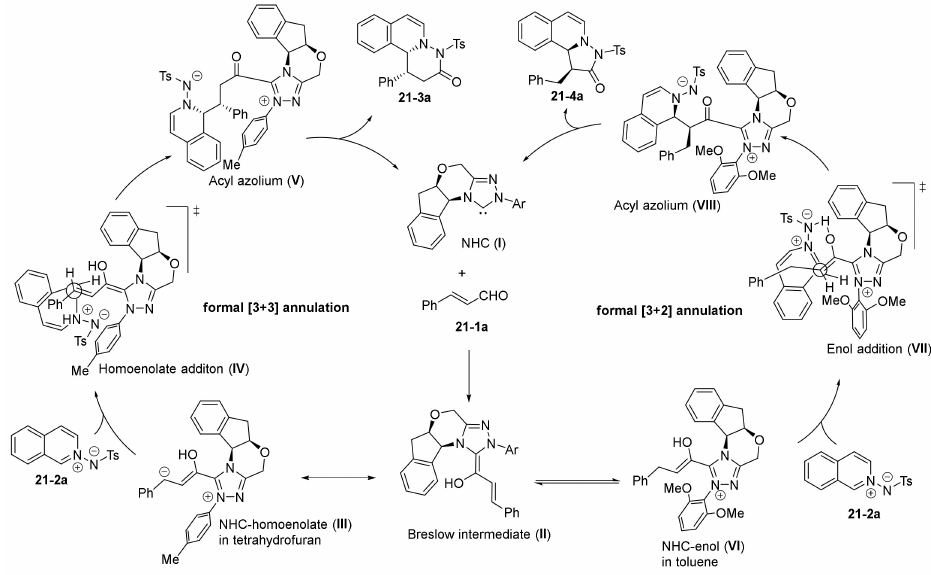
Scheme 42. Proposed reaction mechanism for NHC-catalyzed switchable annulation